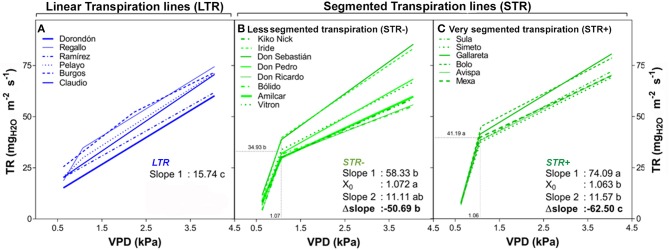
Transpiration rate (TR) of 20 durum wheat lines exposed to increasing VPD regimes as described in Table 3. Plantlets were growth in pots under well-watered conditions in a greenhouse and the transpiration response was tested in a growth chamber as indicated in the Materials and Methods. Each curve expresses the mean TR values across low to high VPD of a particular line. Plants were tested at the vegetative stage and values represent the mean of five plants (i.e., five biological replicates) per line. (A) The linear regressions of the linear transpiration lines (LTR), and (B,C) the segmented regressions of the segmented transpiration lines [R: less segmented transpiration (STR−) and very segmented transpiration (STR+)] are shown. All panels show the comparison according to the LSD test (p < 0.05) indicating the mean slope of the TR response before and after (Slope 1 and 2) putative VPD breakpoints (X0) and their slope variation (Δslope).